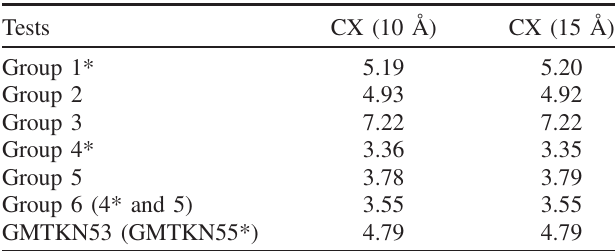
ACCURATE NONEMPIRICAL RANGE-SEPARATED HYBRID VAN assessments: Pilot study comparison of characteristic WTMAD1 values [17,69] (in kcal/mol) as obtained for “ GMTKN53, ” a 53- benchmark part [17] of the GMTKN55 suite [69]. We contrast the plane-wave performance characterizations that result when using a standard 10-Å and a larger 15-Å choice of vacuum padding (see text). The convergence tests are done for the ABINIT PP set [234], at 80-Ry wave-function cutoff. We focus on the “ easily accessible GMTKN53 ” subsuite [17] that excludes (as indicated by aster- isks) the G21EA benchmark set from the GMTKN55 [69] group 1 and the WATER27 set from the GMTKN55 group 4. This is done because these sets require a separate dielectric handling [193,236]; see Appendix A.